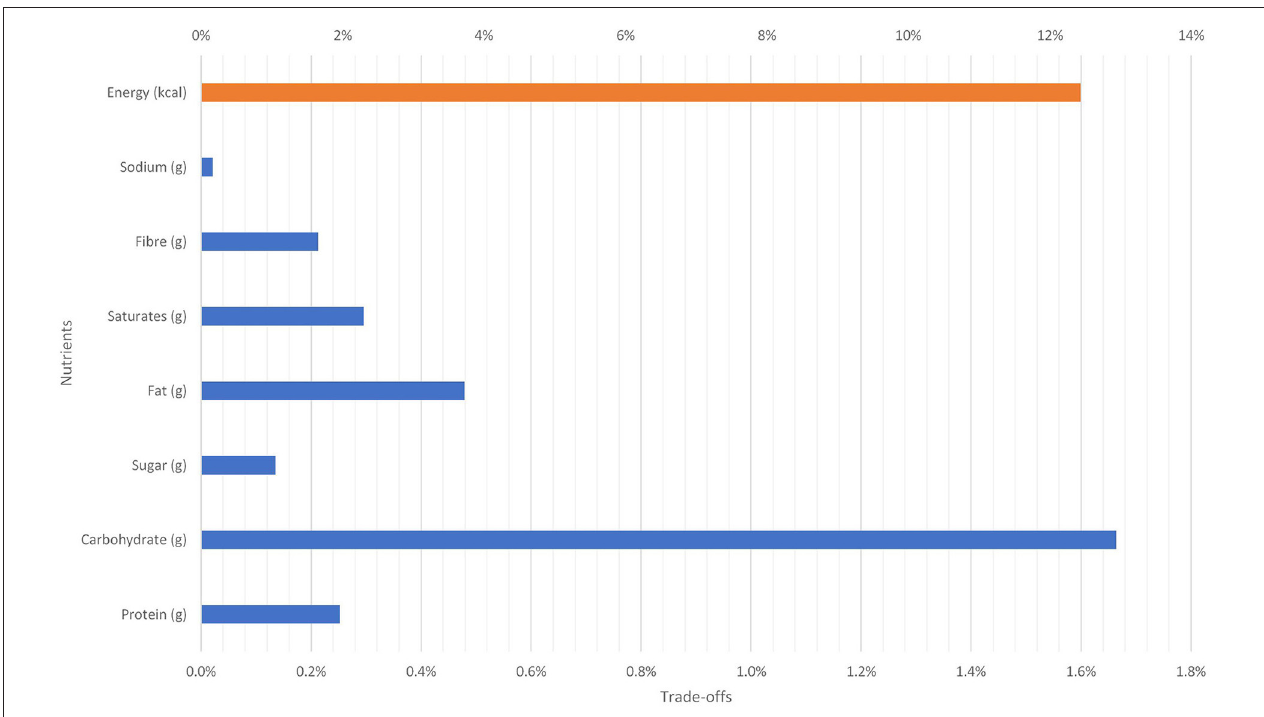
FIGURE 10 | Nutritional trade-off due to 10% reduction in the price of mashed potatoes on baking potatoes.